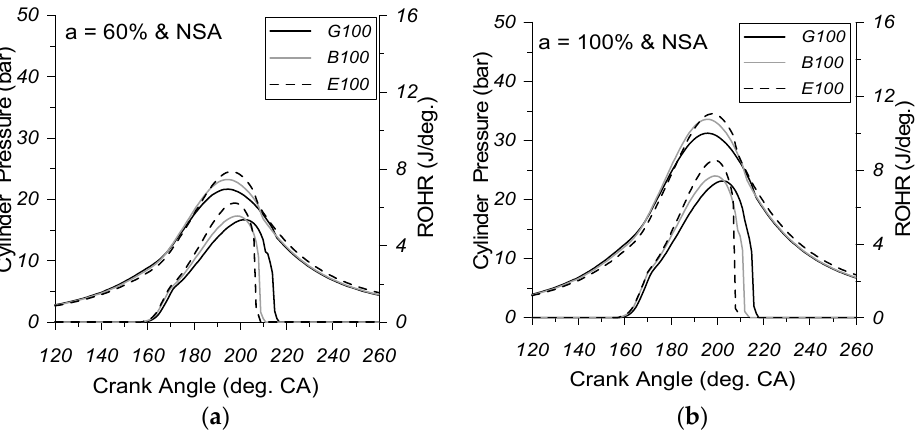
Figure 4. Calculated cylinder pressure and heat release rate traces for G100, B100 and E100 fuel operating modes, normal spark timing at 2400 rpm and 60% load ( a ); and 2400 rpm and 100% load ( b ).